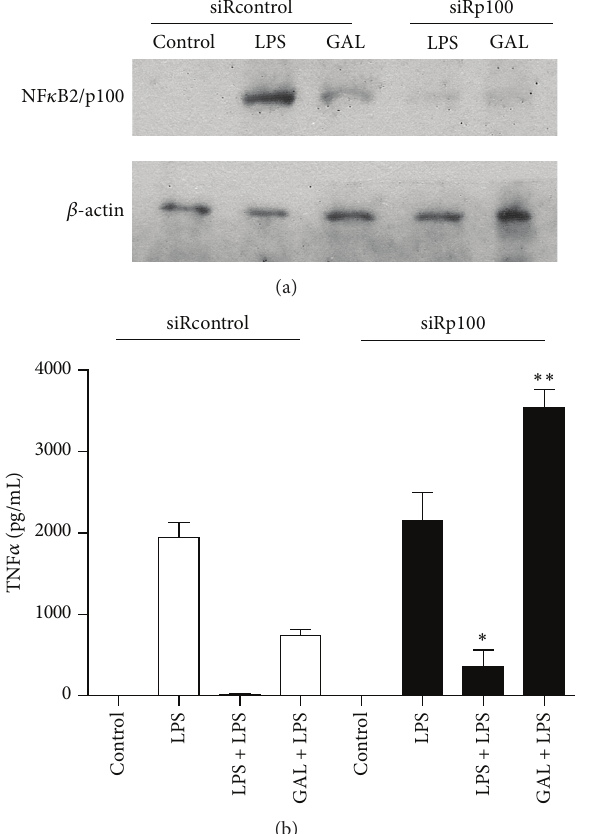
Figure 5: The attenuated inflammation effect induced by GAL is reverted by small interfering RNA of NF 𝜅 B2/p100. Cultures of siRp100andsirRcontroltransfectedhumanmonocyte/macrophages were treated with 10g/mL GAL or 10 ng/mL LPS for 24 h. The controls were not treated. The levels of NF 𝜅 B2/p100 and 𝛽 -actin were studied by Western blot analysis of the cytosolic fraction. (a) A NF 𝜅 B2/p100 and 𝛽 -actin standard blot are shown ( 𝑛 = 5 ). (b) TNF protein level was evaluated by CBA ( 𝑛 = 4 ); ∗ 𝑝 < 0.05 , ∗∗ 𝑝 < 0.01 compared with